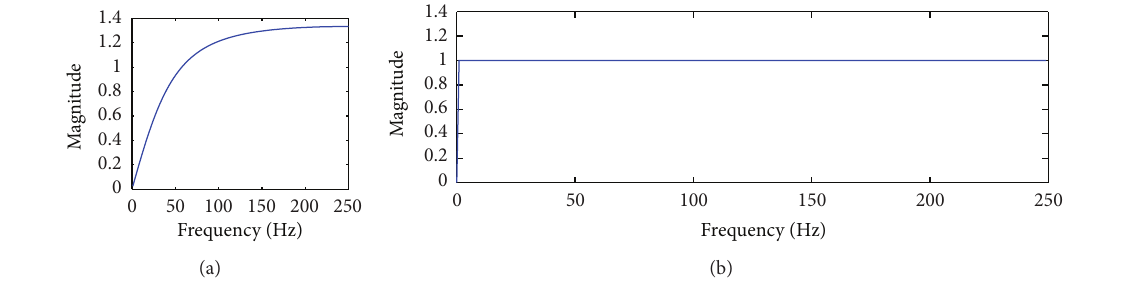
Figure 4: Transfer function for two choices of adaptive notch filters (a) 𝐶 = 1 ; (b) 𝐶 = 0.01 .